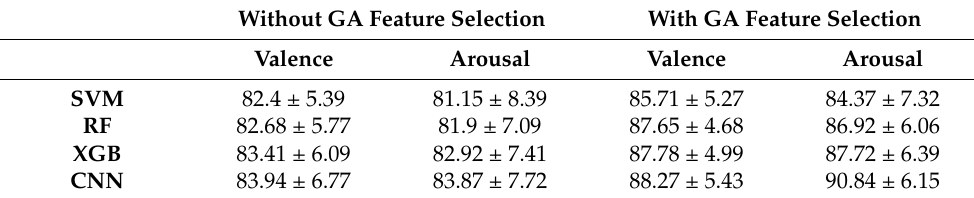
Table 3. Comparative accuracy results from the experimental analysis of all subjects (mean ± standard deviation) with and without the use of GA-based feature selection. The first two columns refer to the case where no feature selection method was implemented. The last two columns refer to the case where feature selection method was